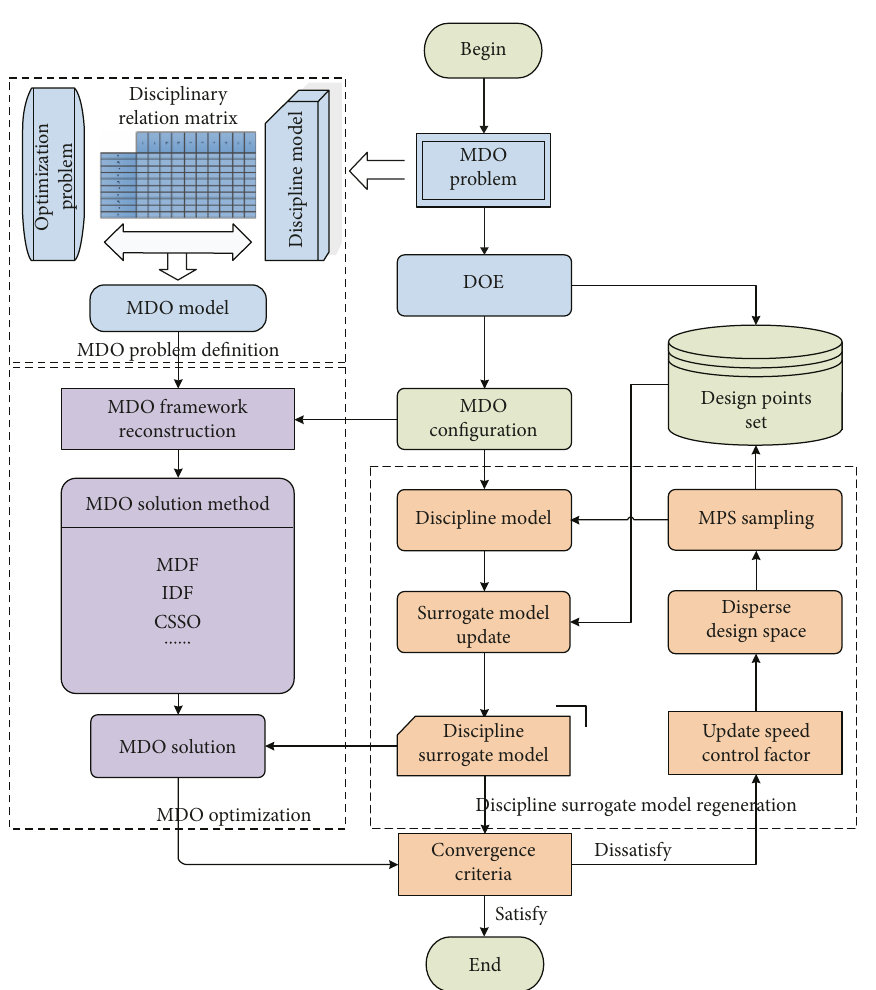
Figure 6: Flowchart of the